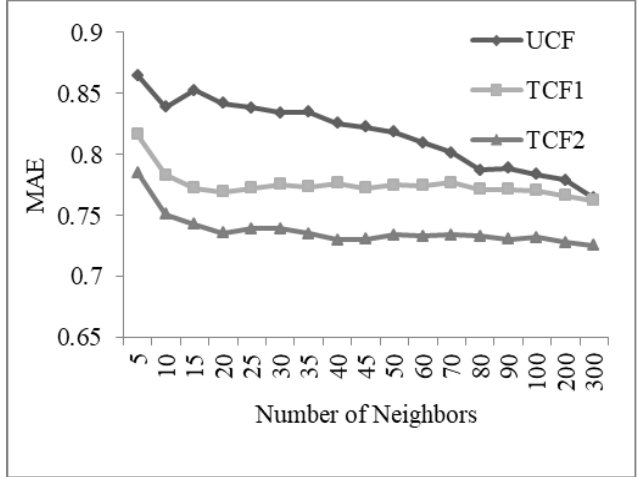
Figure 11. MAE with changing of the number of neighbors.